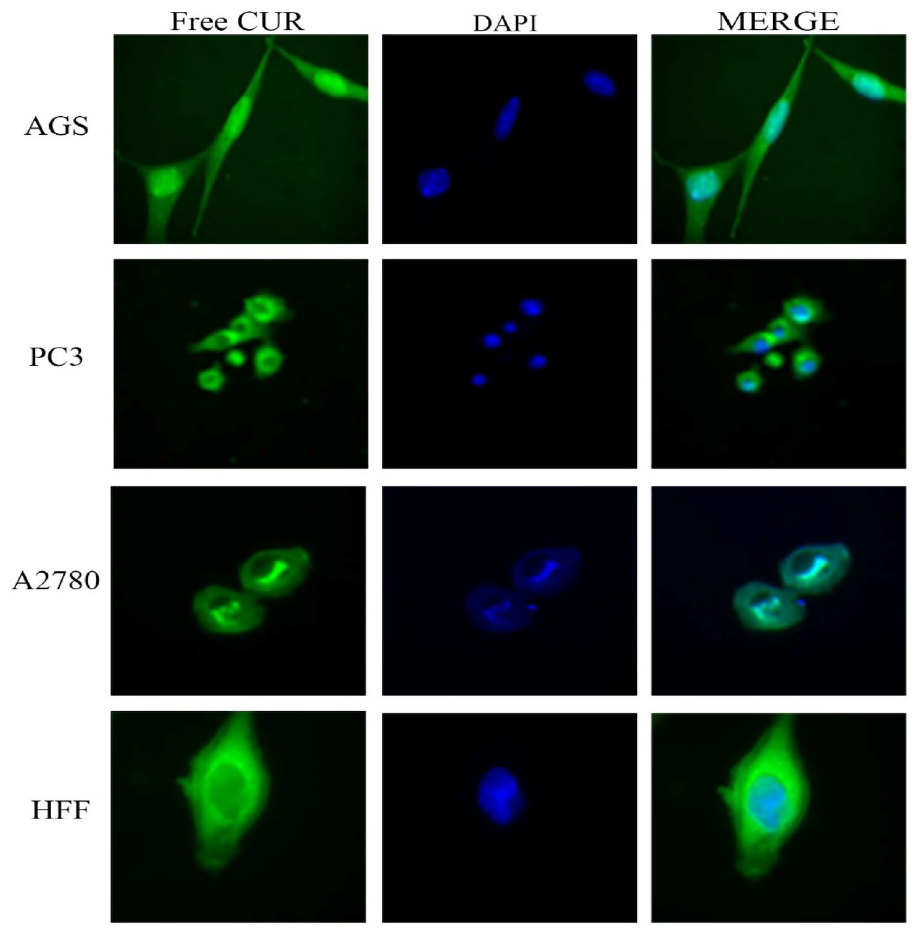
Figure 3. Cellular uptake images of AGS, PC3, A2780 and HFF cells incubated with free CUR for 180 min. DAPI (blue) was used for nucleus